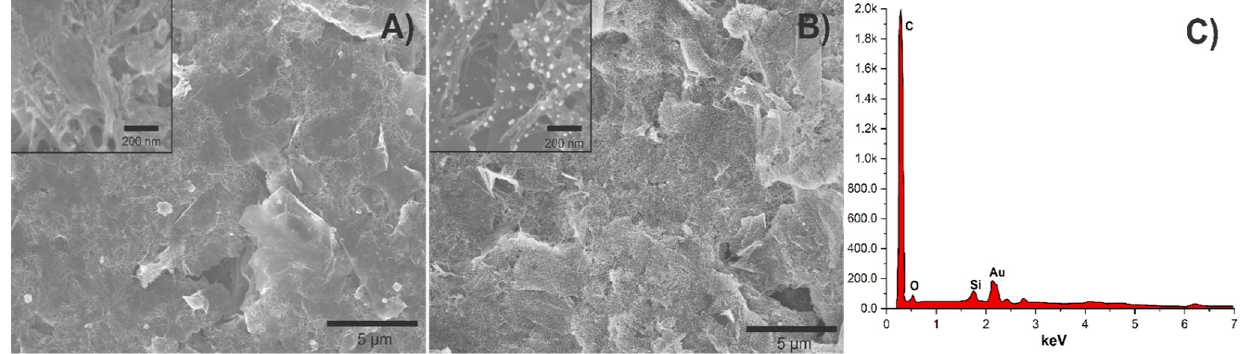
Figure 2. SEM images of ( A ) ErGO-cMWCNT, ( B ) ErGO-cMWCNT/AuNPs, and ( C ) EDS of ErGO-cMWCNT/AuNPs.